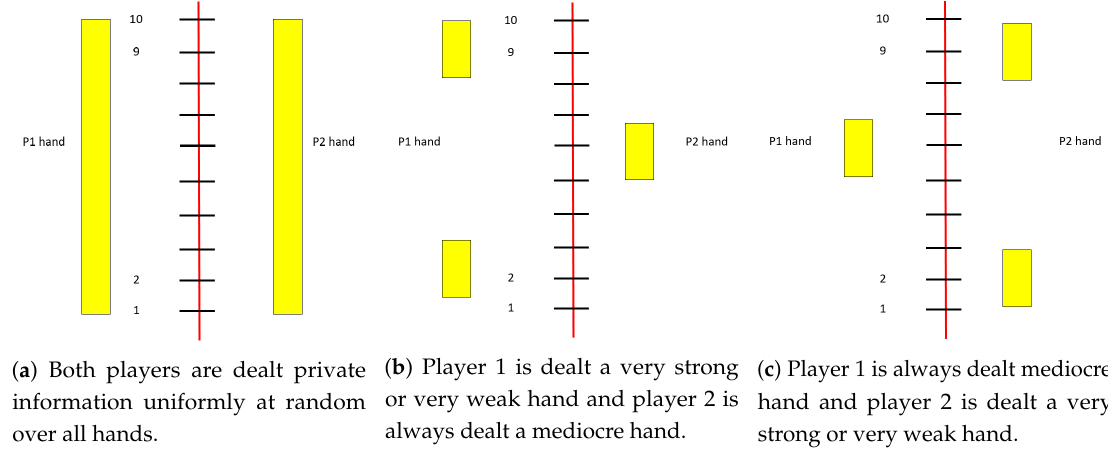
Figure 1. Three example hand distributions defining simplified poker games. The Y-axis is the hand, from 1 (worst possible hand) to 10 (best possible). For each figure, the boxes on the left denote player 1’s distribution of hands, and the boxes on the right denote player 2’s hand